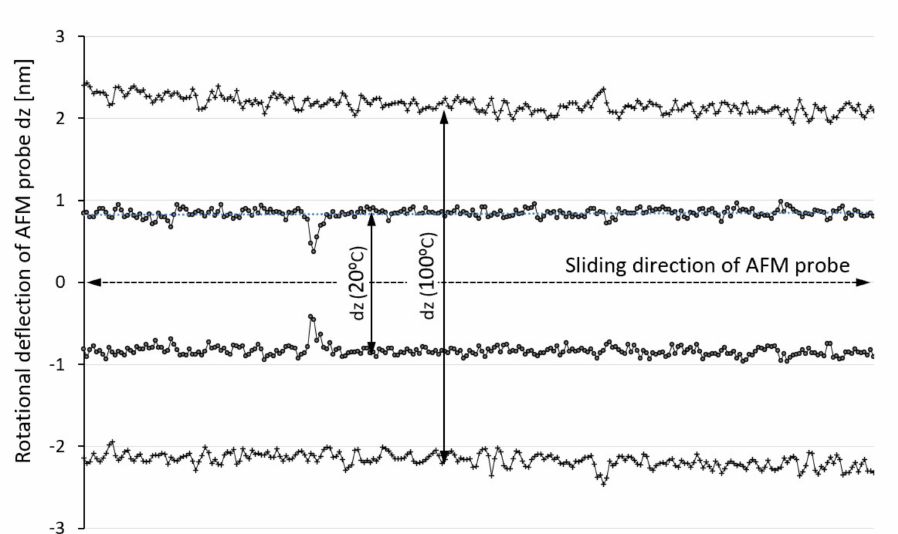
Figure 10. Rotational deflection (dz) of AFM probe during sliding on SU-8 hard baked at 125 ◦ C, tested at 20 ◦ C and 100 ◦